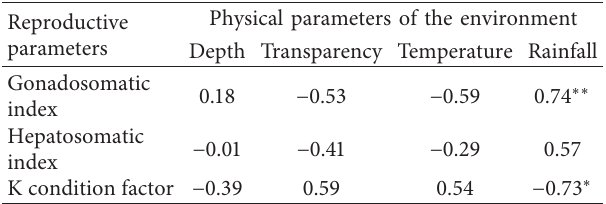
Figure 5: Monthly evolution of HSI by sex of C. nigrodigitatus between October 2015 and August 2016 in the Nkam River. 00.511.522.5 Figure 6: Monthly variation of K factor by sex of C. nigrodigitatus between October 2015 and August 2016 in the Nkam River. Table 1: Correlation between reproduction parameters of C. nigrodigitatus and physical parameters of the environment in the Nkam River.